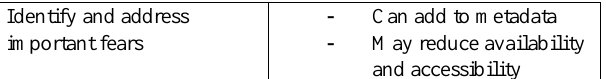
Table 3. Other rules of OGD working